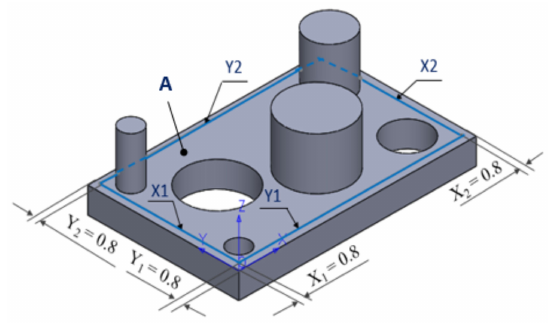
Figure 15. Definition of the measured linear